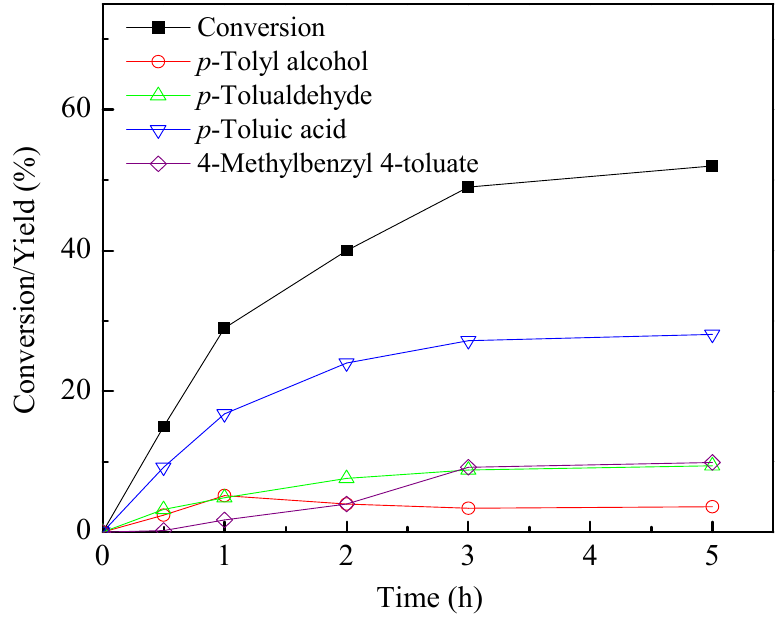
Figure 4. The influence of time; reaction conditions: p -Xylene (100 mmol),